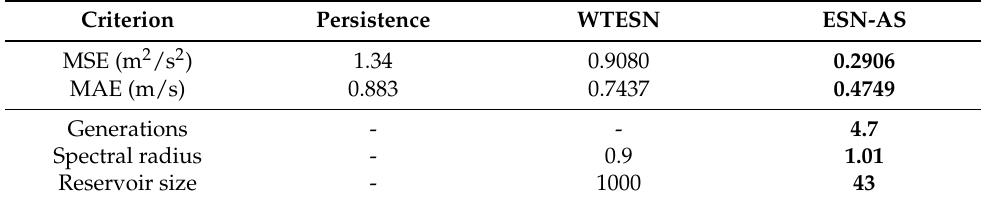
Table 7. Average test